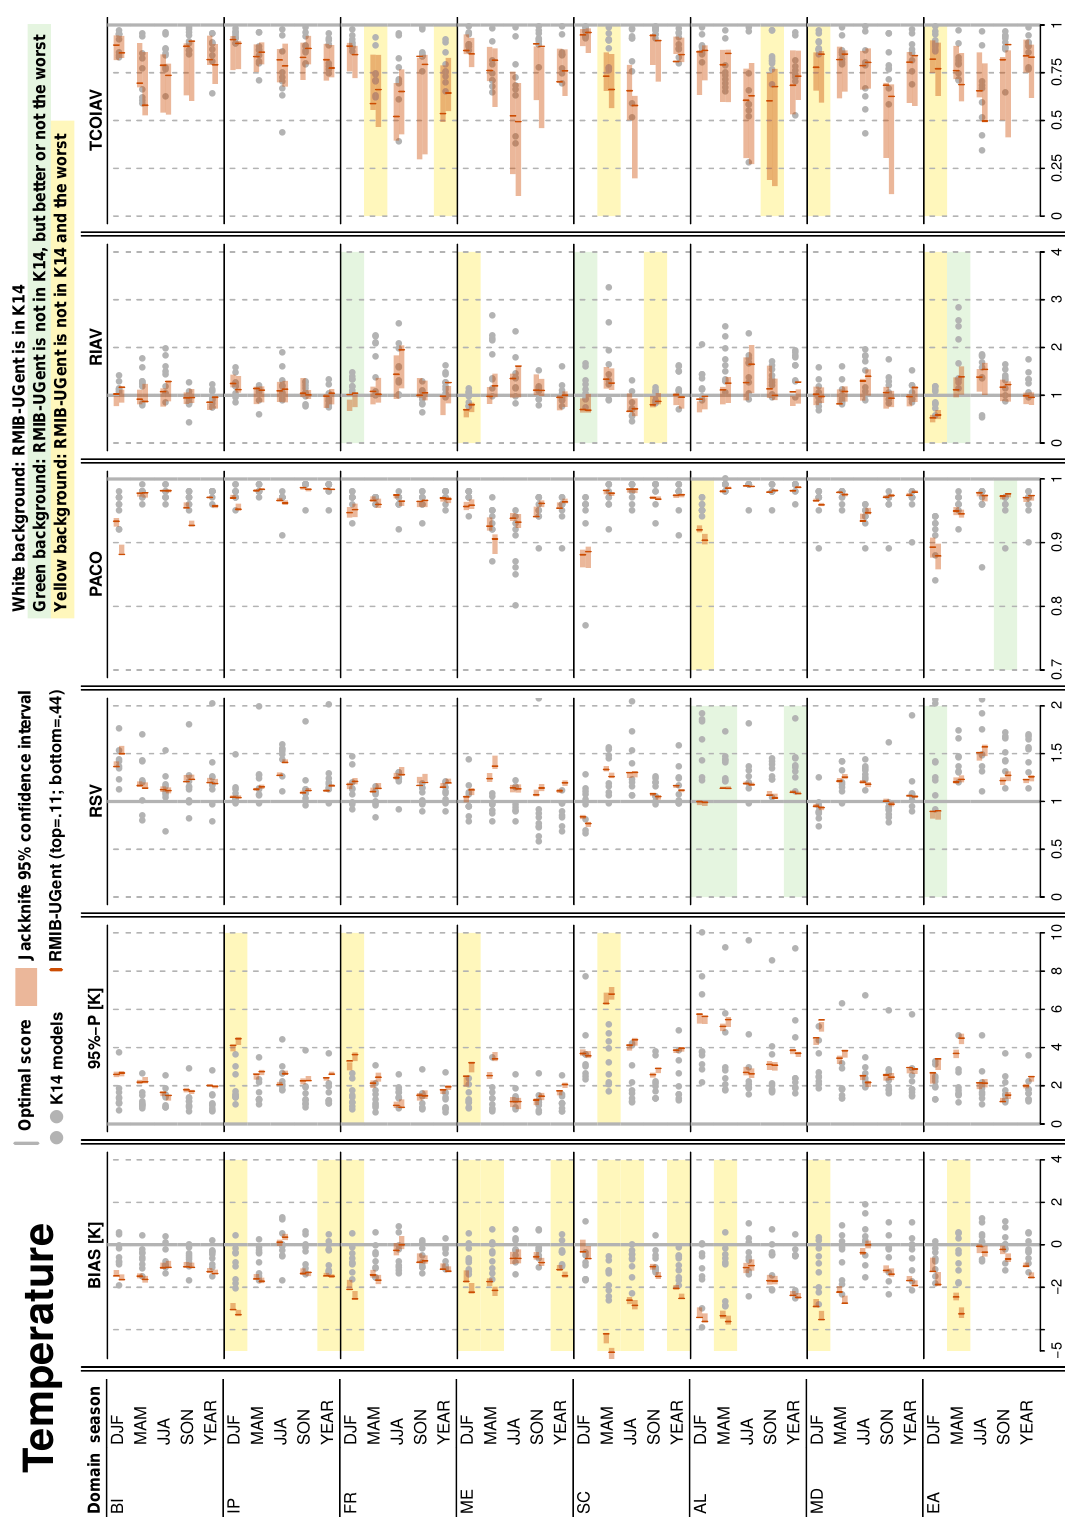
Figure 3. Scores for near-surface air temperature for all domains (first column), seasons (second column) and